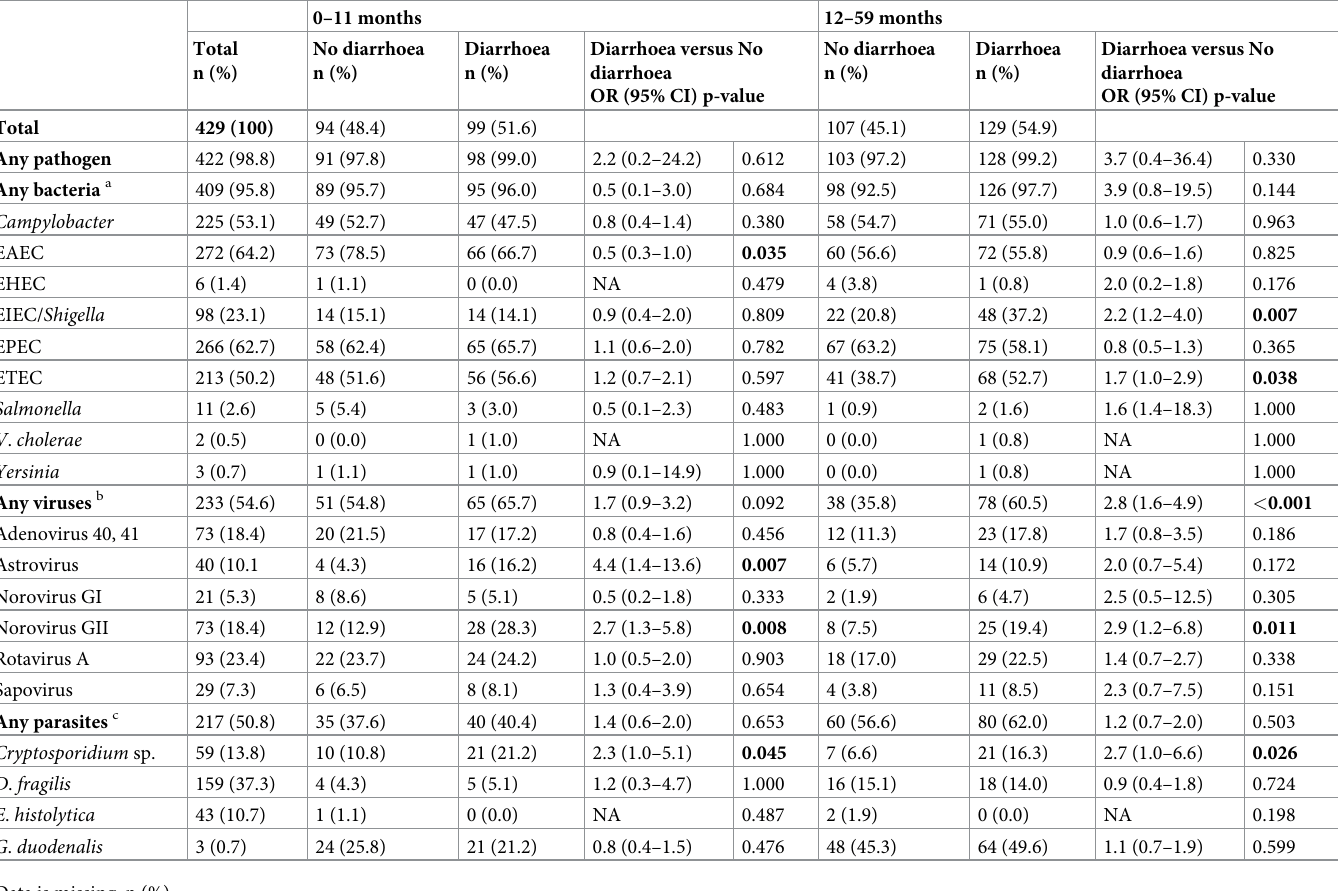
Table 3. Diarrhoeal pathogens in 429 children with and without diarrhoea divided into two age groups: infants (0–11 months) and young children (12–59